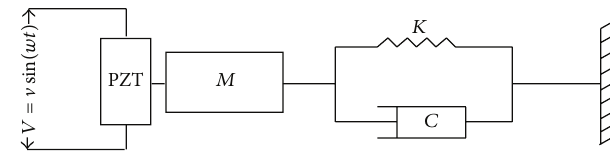
Figure 1: One-dimensional model of EMI